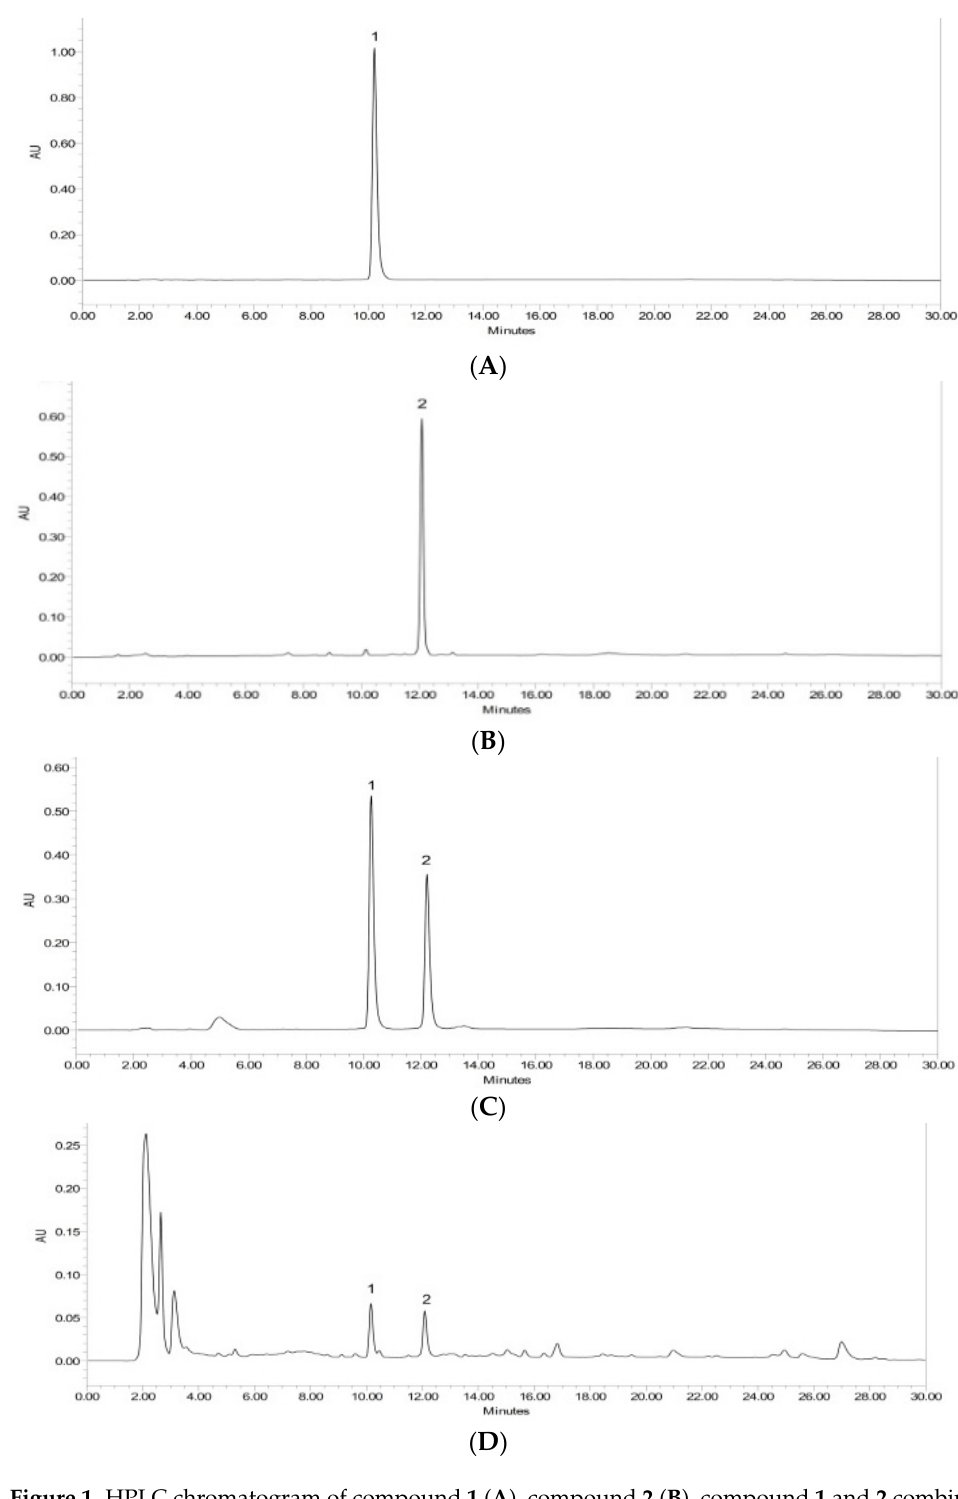
Figure 1. HPLC chromatogram of compound 1 ( A ), compound 2 ( B ), compound 1 and 2 combined ( C ), and ethanol extract of yacon ( D ).